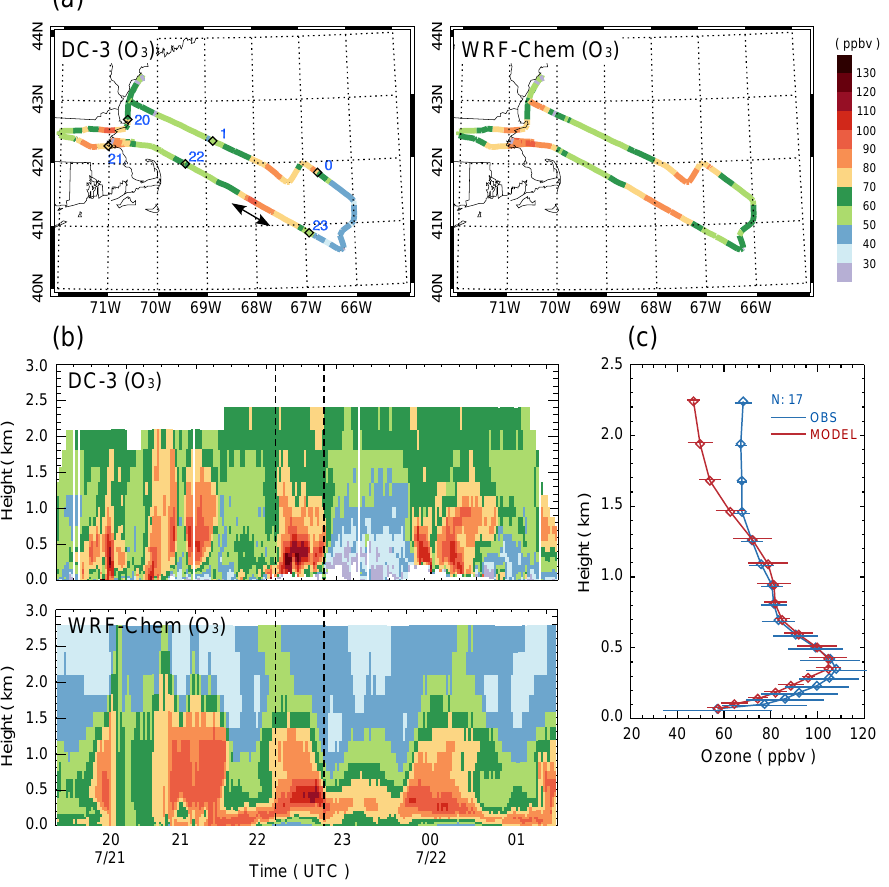
Fig. 8. (a) Horizontal distributions of observed and simulated O 3 mixing ratios measured from the DC-3 aircraft on 21 July. The ozone mixing ratios are vertically averaged from near surface to about 1.5km. (b) Vertical distributions of observed (top) and simulated (bottom) O 3 mixing ratios on 21 July as a function of time. (c) Mean profiles and standard deviations of observed and simulated O 3 mixing ratios in an ozone plume denoted by the double-headed arrow in (a) and dashed lines in (b)